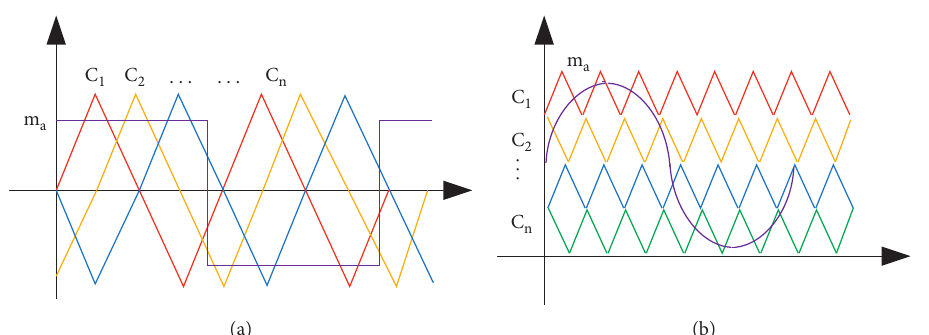
Figure 2: Modulation strategies. (a) CPS-PWM and (b) CAM-PWM.